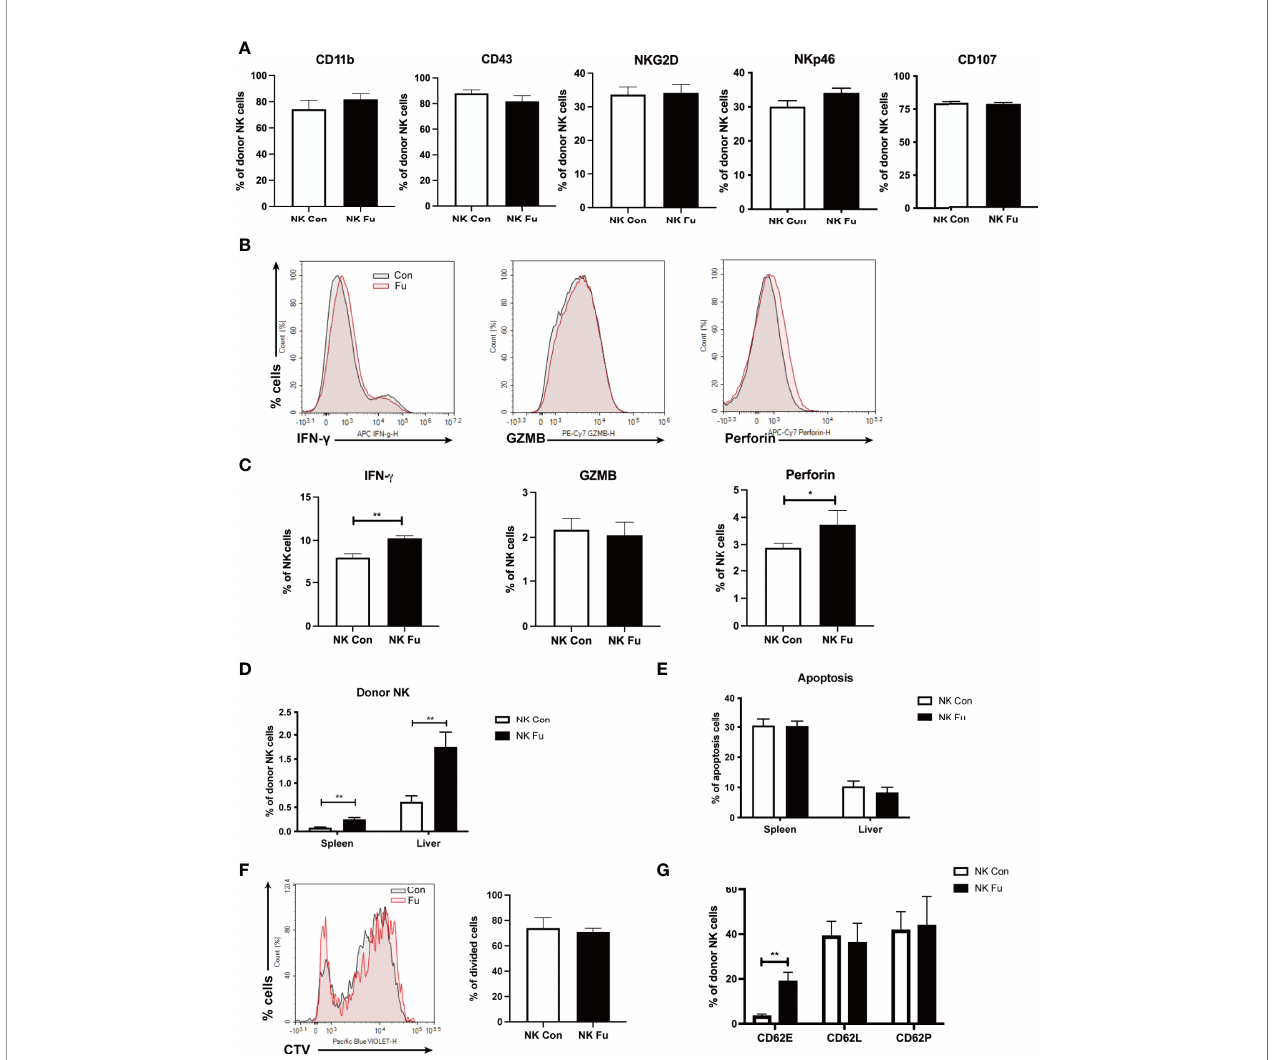
FIGURE 5 | Fucosylation promoted donor NK cells accumulation after allo-HSCT. BALB/c recipients were lethally irradiated and transplanted of 5x10^6 BM cells together with 5×10^6 A20- luc + /yfp cells. Recipients were transferred with 1x10^6 control NK cells or fucosylaed NK cells, respectively. (A) Expressions of CD11b, CD43, NKG2D, NKp46, and CD107 of NK cells in the spleen from mice infused with control or fucosylated NK cells (n = 5-6 per group). (B, C) Representative fl ow cytometry plots and summary data of the frequencies of IFN- g , GZMB and perforin of NK cells from mice infused with control or fucosylated NK cells (n = 5-6 per group). (D) Percentages of donor NK cells in the spleen and liver in recipients were detected by fl ow cytometry 7 days after allo-HSCT (n = 5-6 per group). (E) Percentages of apoptosis of control and fucosylated NK cells in spleen and liver are depicted. (F) Control and fucosylated NK cells were labeled with CTV. The proliferation of CTV labeled control and fucosylated NK cells were detected by fl ow cytometry 4 days post transfer (n = 4-6 per group). (G) Binding abilities of control and fucosylated NK cells to CD62E, CD62L and CD62P in vivo was detected by fl ow cytometry (n = 3-6 per group). Data are representative of three independent experiments and shown as mean ± SD. * p < 0.05; ** p <